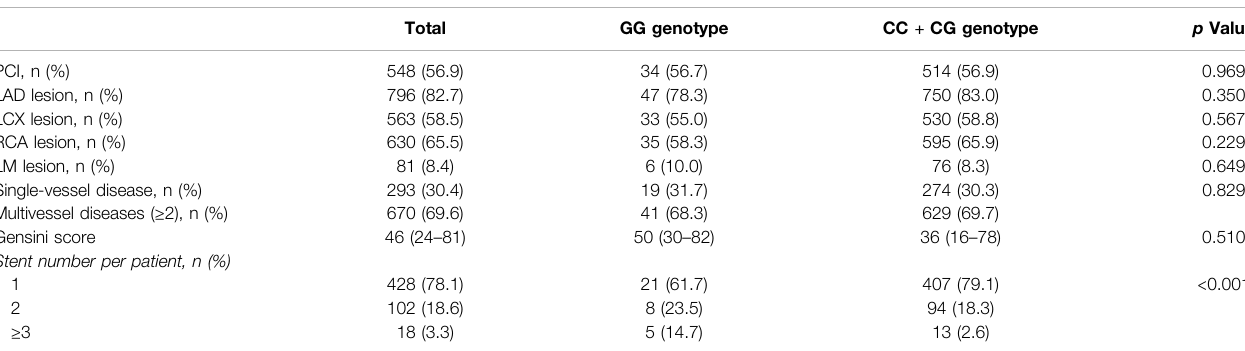
TABLE 4 | Interventional data in ACS patients and recessive model